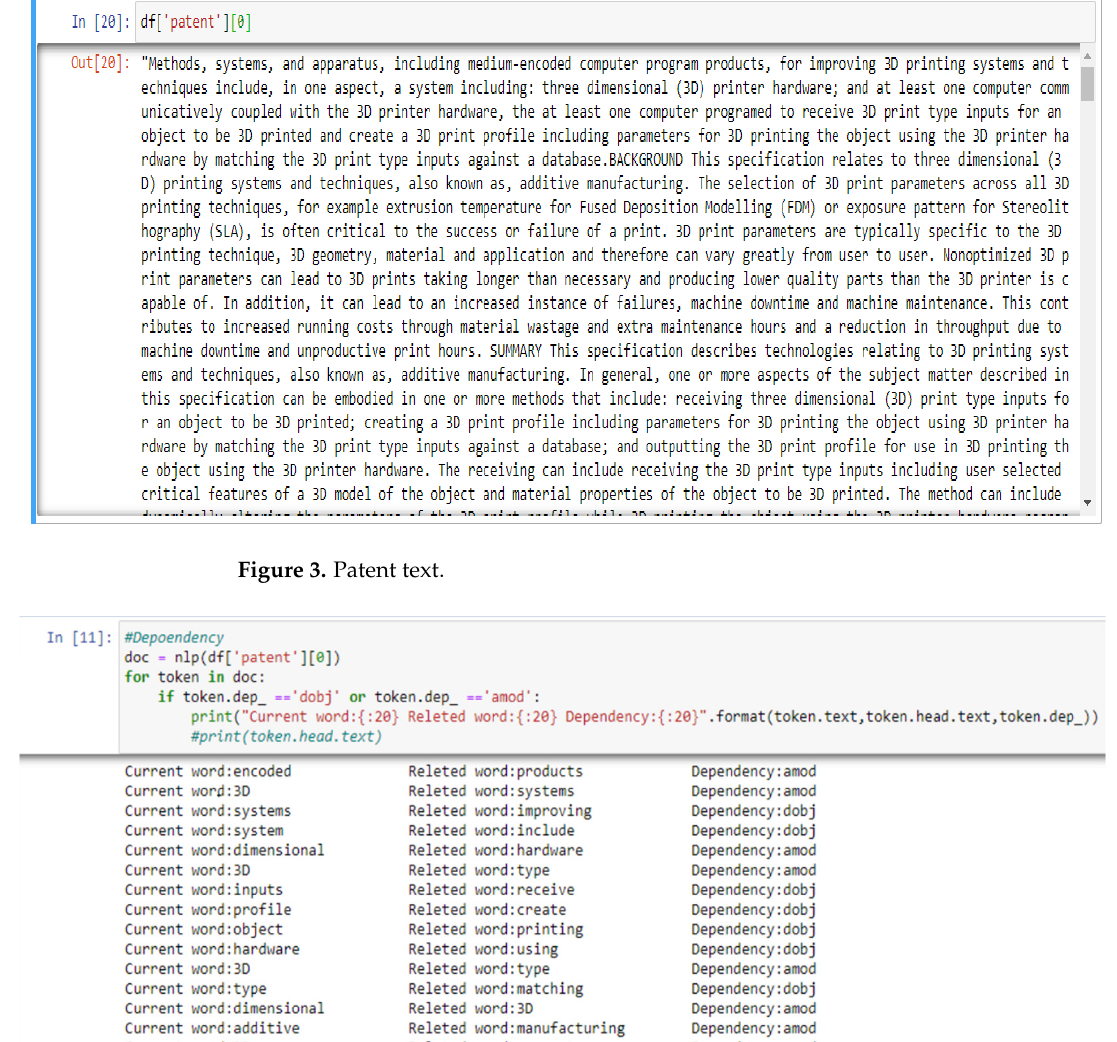
Figure 4. Dependency parsing of patent texts.